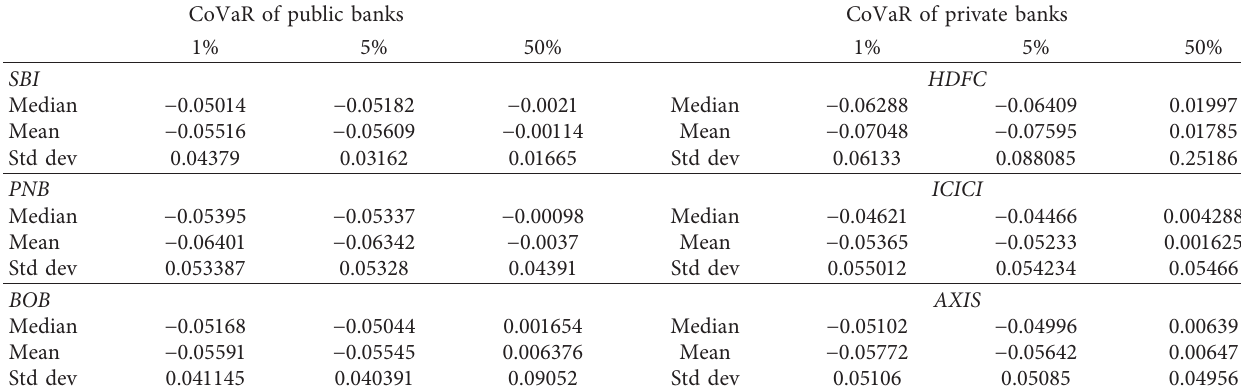
Table 6: Summary of time-varying CoVaR